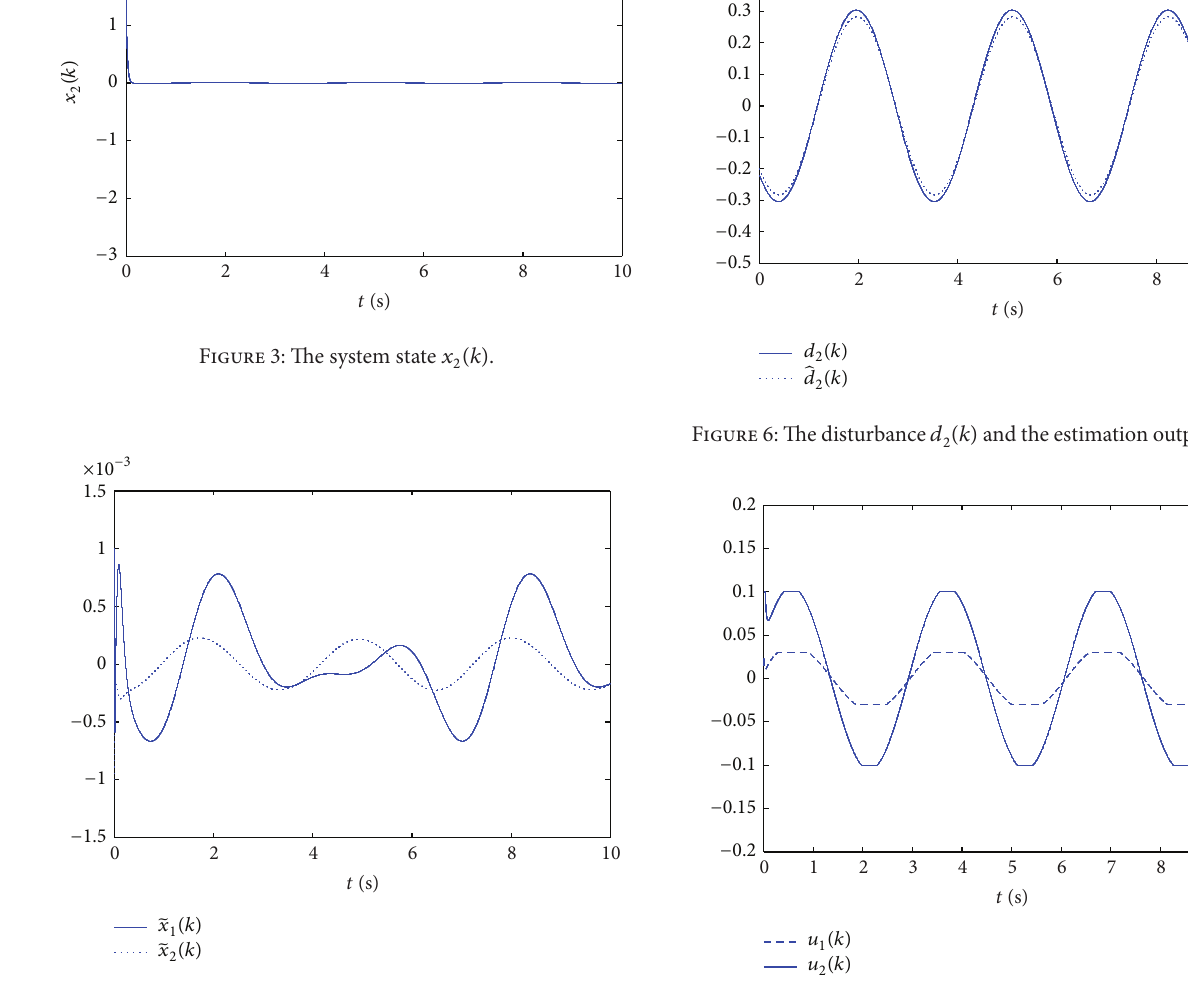
Figure 4: The estimation error outputs of ̃𝑥 1 (𝑘) and ̃𝑥 2 (𝑘) .